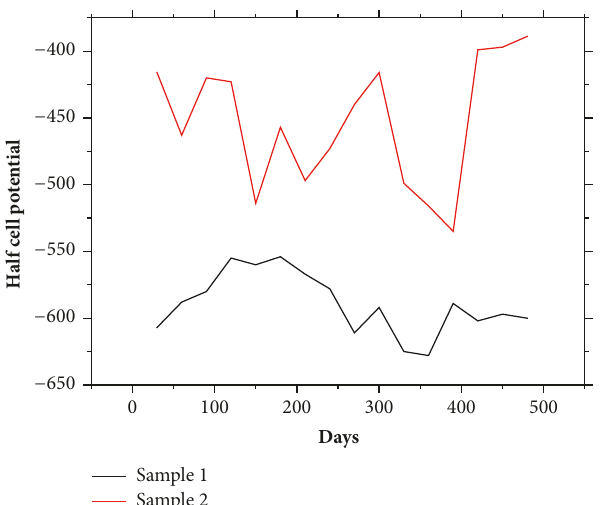
Figure 5: Variation of half cell potentials of steelreinforcementin contaminated concretein the absence (SAMPLE 1) and presence(SAMPLE 2) of SLS during 480 days.